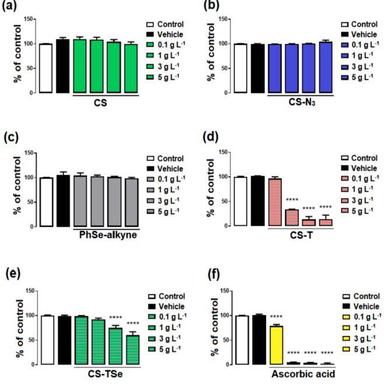
Effect of (a) CS, (b) CS-N3, (c) PhSe-alkyne, (d) CS-T, (e) CS-TSe and (f) Ascorbic acid at different concentrations (0.1–5 g L− 1 ) on DPPH radicalscavenging activity. Data are expressed as the mean ± SEM for three independent experiments, carried out on different days. The results are calculated as % of control of the absorbance at λ = 517 nm. Asterisk denotes significance levels when compared with the control group: (\\\\) P < 0.0001 (One-way ANOVA followed by the Tukey's test).